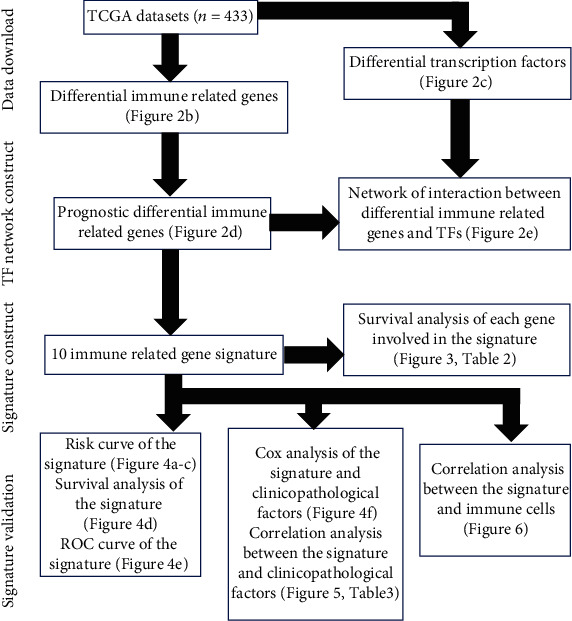
The workflow demonstrating the schematic overview of the project.